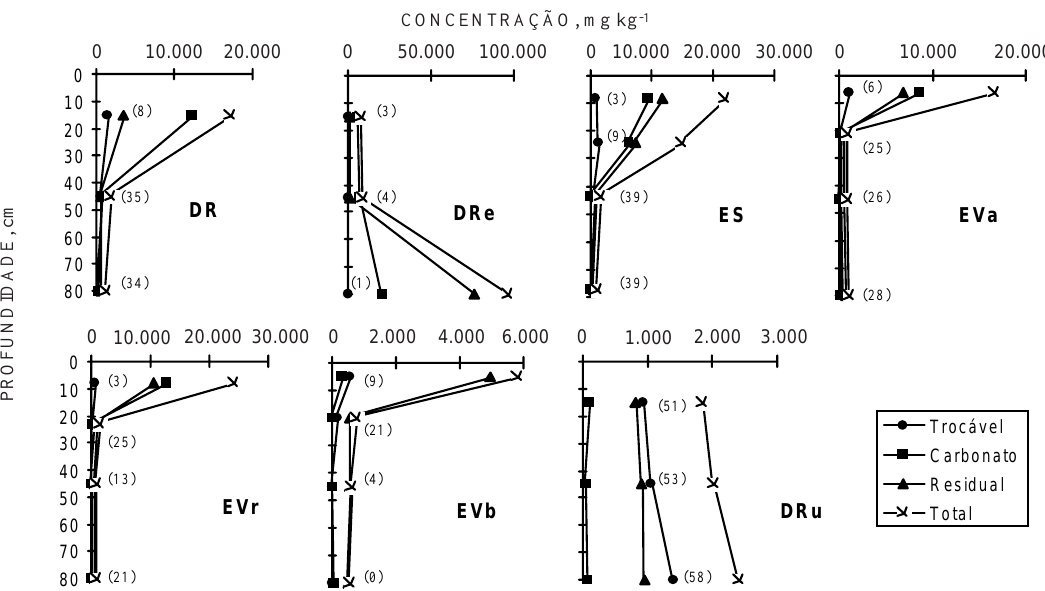
Figura 2. Formas químicas e teores de Zn no solo nos diversos locais e profundidades amostradas. Os números entre parênteses representam a percentagem do teor trocável do elemento em relação ao total. DR-área de deposição sem vegetação; DRe-área de deposição plantada com eucalipto; ES-área sob influência de escoamento sem vegetação; EVa-área com vegetação de cerrado arbóreo-arbustivo sem vegetação rasteira; EVr-área com vegetação de cerrado arbóreo-arbustivo com vegetação graminóide; EVb-área com Brachiaria ; DRu-área de deposição dos resíduos da